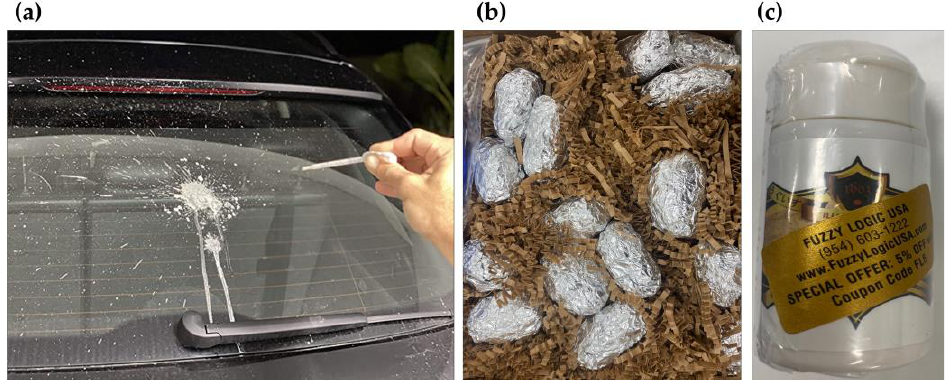
Figure 2. Type of bird droppings ( a ) Fake poop, ( b ) owl droppings, ( c ) UGUISU.